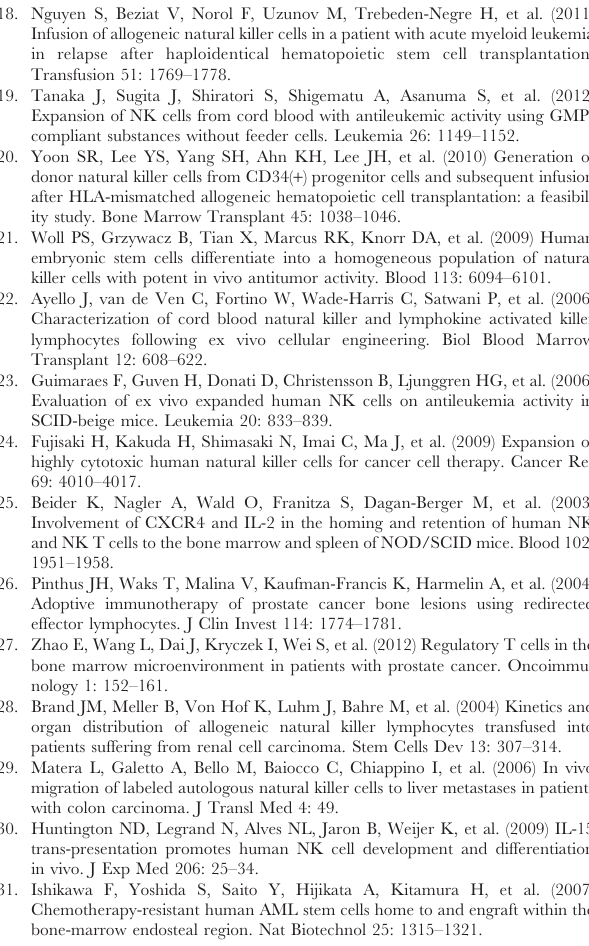
Figure S2 Low-dose IL-15 mediates efficient UCB-NK cell survival and expansion in vivo . Adult NSG mice were injected i.v. with 10 6 10 6 UCB-NK cells with or without supportive IL-15. Recombinant human IL-15 was administered daily for 2 weeks at the dose of 0.5 m g/mouse/injection, starting the day of UCB-NK cell infusion. Human NK cells were quantified weekly in peripheral blood by flow cytometric analysis. (A) Percentage of human CD45 + CD56 + cells in blood of mice injected with UCB-NK cells alone (dotted line, n =5) or UCB-NK cells with IL-15 (straight line, n= 6) over time. (B) Representative dot-plots obtained 2 weeks after UCB-NK cell infusion.